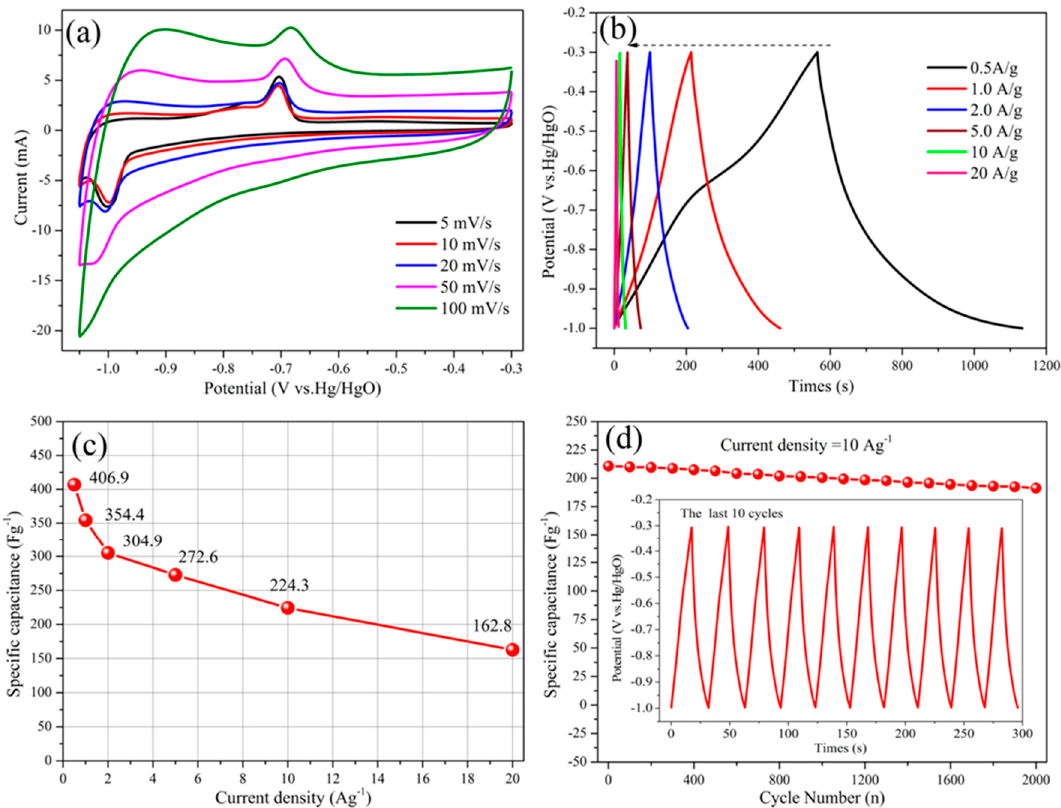
Figure 8. ( a ) CV curves of α -Fe 2 O 3 @C electrodes at different scan rate; ( b ) charge-discharge curves of α -Fe 2 O 3 @C electrodes at different current density; ( c ) the specific capacitance of α -Fe 2 O 3 @C electrodes at different current densities; ( d ) cycling stability of α -Fe 2 O 3 @C electrodes at the current density of 10 Ag − 1 , the insert is the last 10 charge-discharge